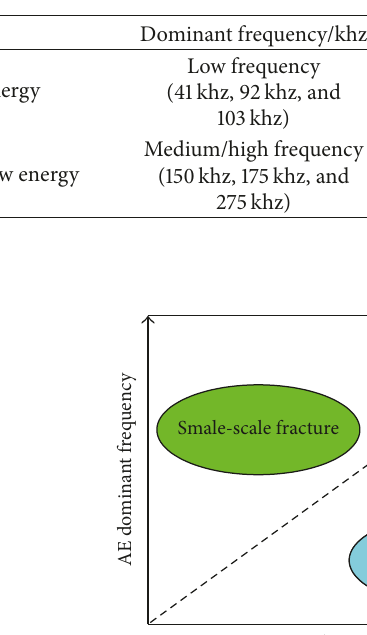
Table 3: Corresponding acoustic emission characteristics of different fracture scale cracks.